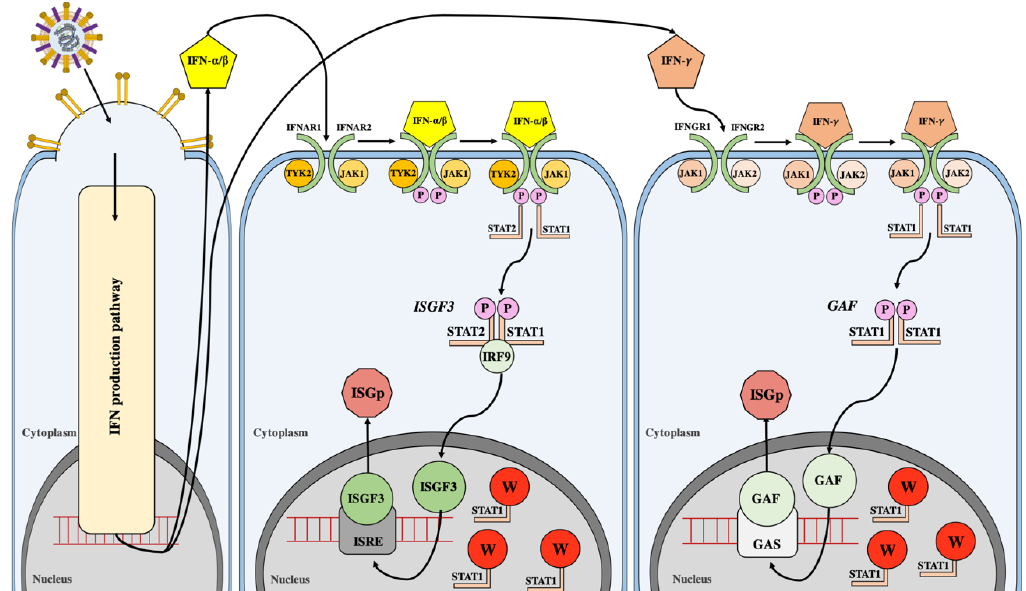
Figure Figure 4. IFN signalling pathway and production of IFN-stimulated gene (ISG) products. Virus- mediated induction of the type I IFN production activates IFN signalling pathways. Type I IFNs (IFNα/β) bind cognate IFNAR receptors that activate Janus kinase (JAK) proteins JAK1 and TYK2. When activated, JAKs phosphorylate STATs. The activated STAT-1 and STAT-2 proteins form heterodimers that associate with IRF-9, creating the ISGF3 complex. ISGF3 associates with coactivators to induce the expression of genes downstream of promoters with IFN-stimulated response elements (ISREs). This upregulates many host antiviral products (ISGp). Type II interferon (IFN-γ) binds IFNGR receptors to stimulate JAK activity and phosphorylation of STAT-1 homodimers (GAF complex). GAF binds promoters of gamma-activated sequences (GAS)-associated genes that upregulate host antiviral products (ISGp). W protein binds and sequesters unphosphorylated STAT in the nucleus as a high molecular weight complex, antagonizing the function of STAT in the JAK- STAT pathway.